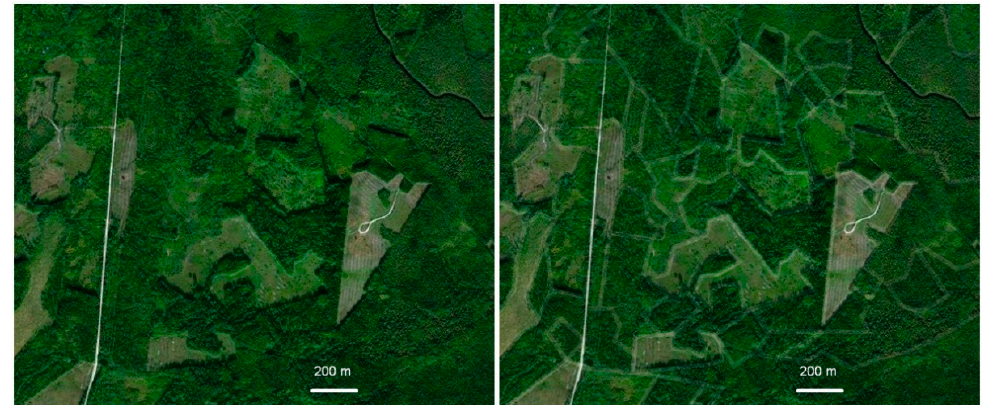
Figure 1. Forest vegetation fragmentation—a mosaic of varying-age clear-cut sites in the study area. Image borrowed from www.bing.com (accessed on 3 February 2022). The original image is on the left; the image on the right has the boundaries between communities in different stages of post-logging regeneration “highlighted”.